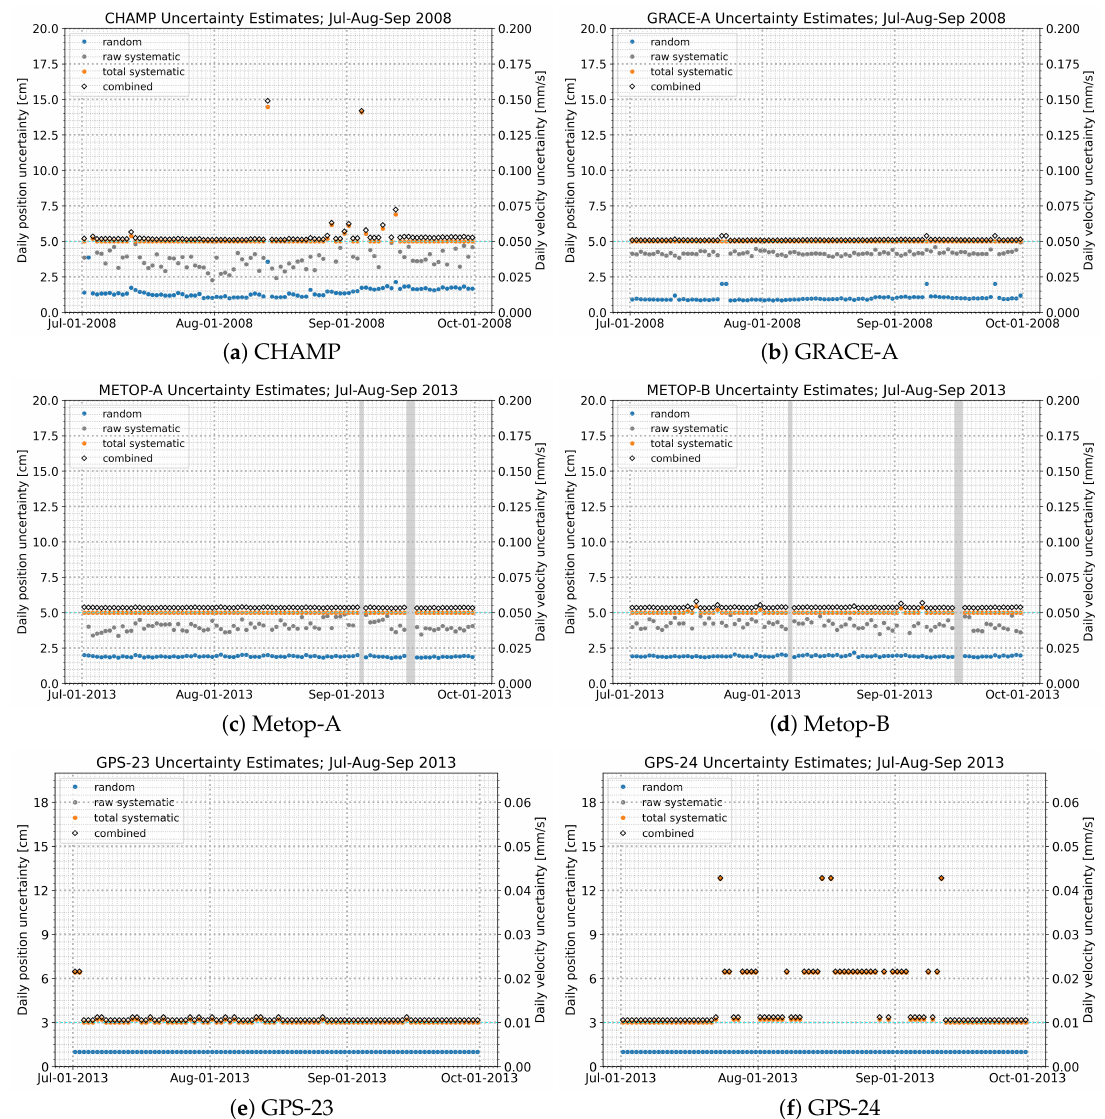
Figure 6. Daily position and velocity uncertainty estimates for the WEGC-Bernese (CODE) primary solution for ( a ) CHAMP and ( b ) GRACE-A from July to September 2008, and for ( c ) Metop-A, ( d ) Metop-B, ( e ) GPS-23, and ( f ) GPS-24 for July to September 2013. The “raw systematic” values denote the estimated systematic uncertainties before applying the conservative bound value ( u CB ) while the “total systematic” values show the estimates including this low-bounding